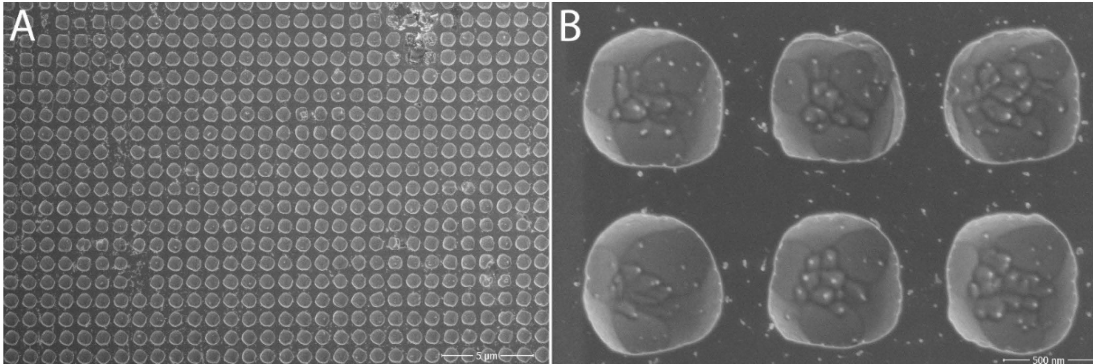
Figure 9. Resulting lattice on tungsten chip: ( A ) overall view; ( B ) detail of the structure of the formed cavities (50 × ). Adapted from [15] with kind permission of Brno University of